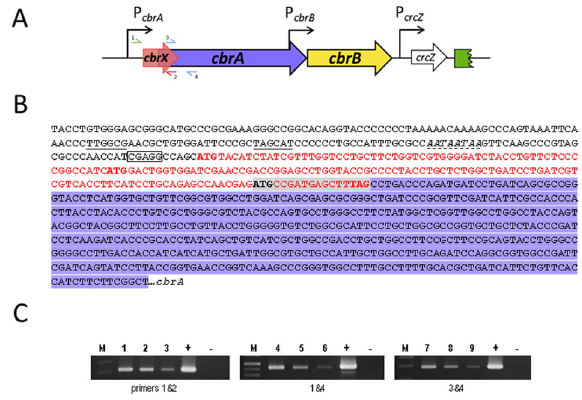
Figure 1. Genomic organisation of the cbrX-cbrA-cbrB cluster in P. putida . ( A ) Graphic representation of the gene organisation of cbrX ( PP5704 in red), cbrA ( PP4695 in purple), cbrB ( PP4696 in yellow) and crcZ ( PPmr53 in white) in Pseudomonas putida KT2442. The promoters for cbrA , cbrB and crcZ are depicted as black arrows. ( B ) DNA sequences for the promoter region and of cbrX and 5 ′ of cbrA in Pseudomonas putida KT2440. Underlined sequences correspond to the putative -10 and -35 boxes, a predicted Crc binding site is shown in italics and with a dotted underline, and the putative RBS for cbrX “CGAGG” is boxed. The coding sequence for cbrX is represented in red characters, that of cbrA is shaded in purple, and the overlapping sequences for cbrX and cbrA are shaded in grey. The start and stop codons are highlighted in bold. ( C ) cbrX and cbrA are co- transcribed in the same transcriptional unit. RT-PCR of 25, 5 and 1 ng of cDNA from a culture KT2442 growing in OAA was amplified with different combination of the primers represented in panel A; primers 1 (RT- PcbrXA_fwd2) and 2 (RT-cbrX_rev) (lines 1 to 3), primers 1 (RT-PcbrXA_fwd2) and 4 (RT-CbrA_rev) (lines 4 to 6) and primers 3 (RT-CbrA_fwd) and 4 (RT-CbrA_rev) (lines 7 to 9). Positive and negative PCR controls ( + and − , respectively) were performed with genomic or no DNA for each pair of oligos (see Methods). M is the DNA molecular weight marker GeneRuler TM 1 Kb Plus DNA ladder (ThermoFisher